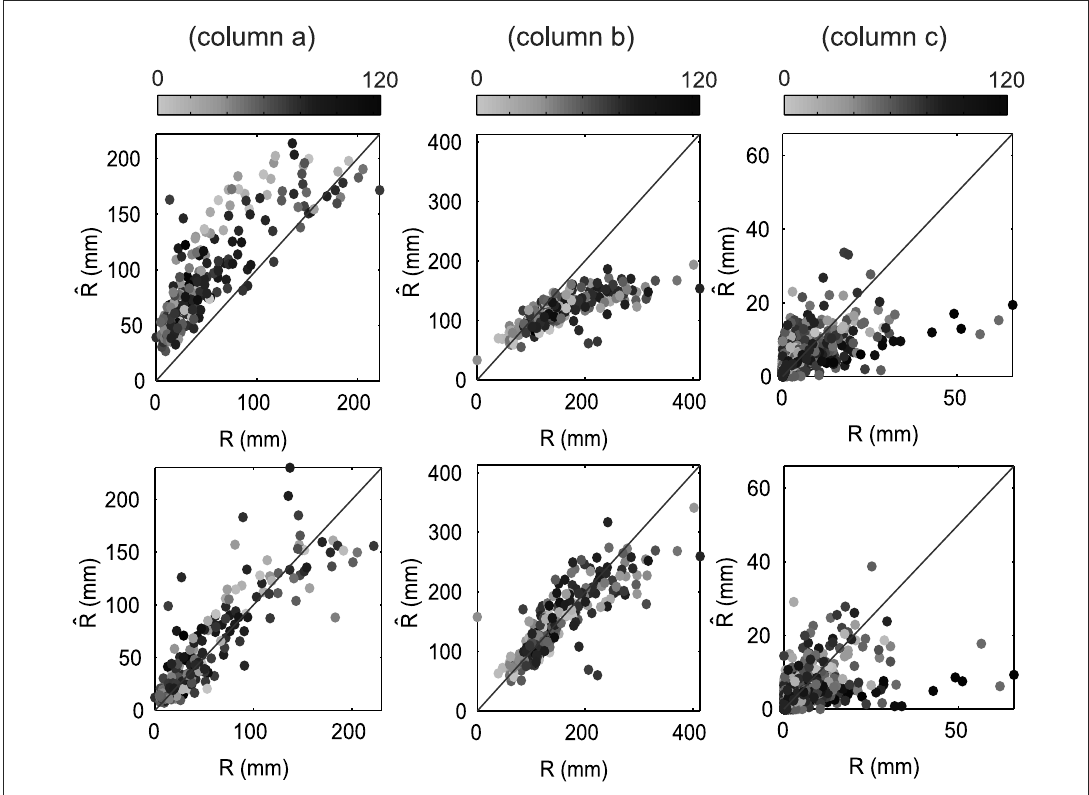
Figure 6. Comparison between observed precipitation and rainfall estimated with the regional formula (top graphs) and with the ATS technique (bottom graphs). The comparison is made at the event scale for event 15 (column a ) and 13 (column b ). Comparison in (column c ) refers to event 3 at the hourly scale. (The grey scale refers to the distance from radar, in